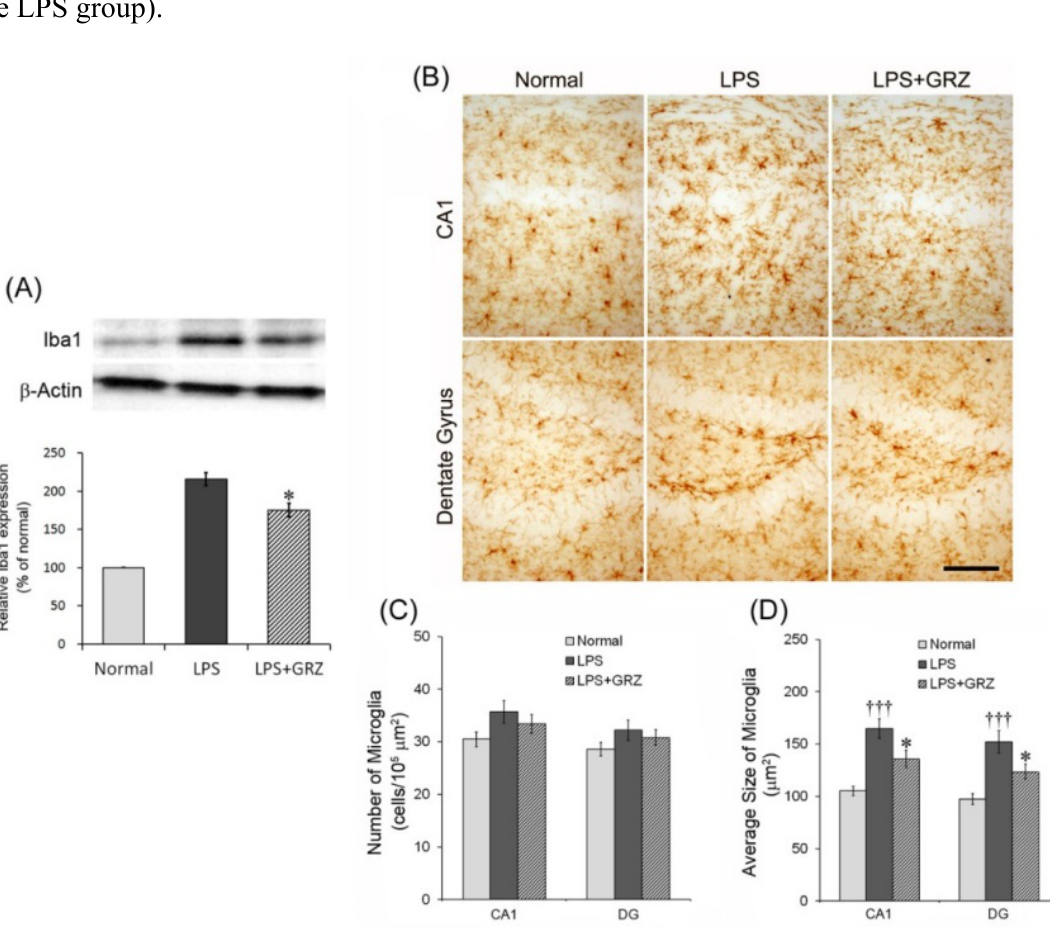
Figure 4. Effects of GRZ on Iba1 protein expression and Iba1-expressing microglia in the hippocampal tissue. Representative western blots illustrating differences in the bands of Iba1 ( A ) GRZ (30 mg/kg) significantly attenuated the up-regulation of hippocampal Iba1 expression of mice which performed the Morris water maze test. Representative Iba1-expressing microglia in the hippocampus of mice which performed the Morris water maze test. Scale bars are 100 μ m ( B ) The numbers of Iba1-expressing microglia were not different between groups ( C ). The average cell size of Iba1-expressing microglia was significantly attenuated at 30 mg/kg of GRZ; and ( D ) Data are represented by mean ± SEM (n = 6 in each group; ††† p < 0.001 compared to the normal group; * p < 0.05 compared to the LPS